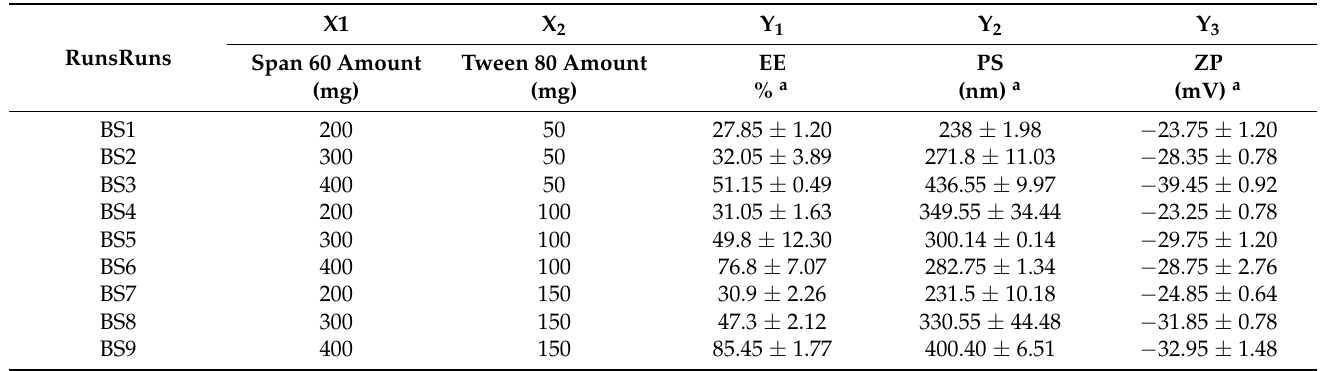
Table 3. Experimental runs, independent variables, and measured response of 3 2 full factorial experimental designs of TOL basic spanlastics.